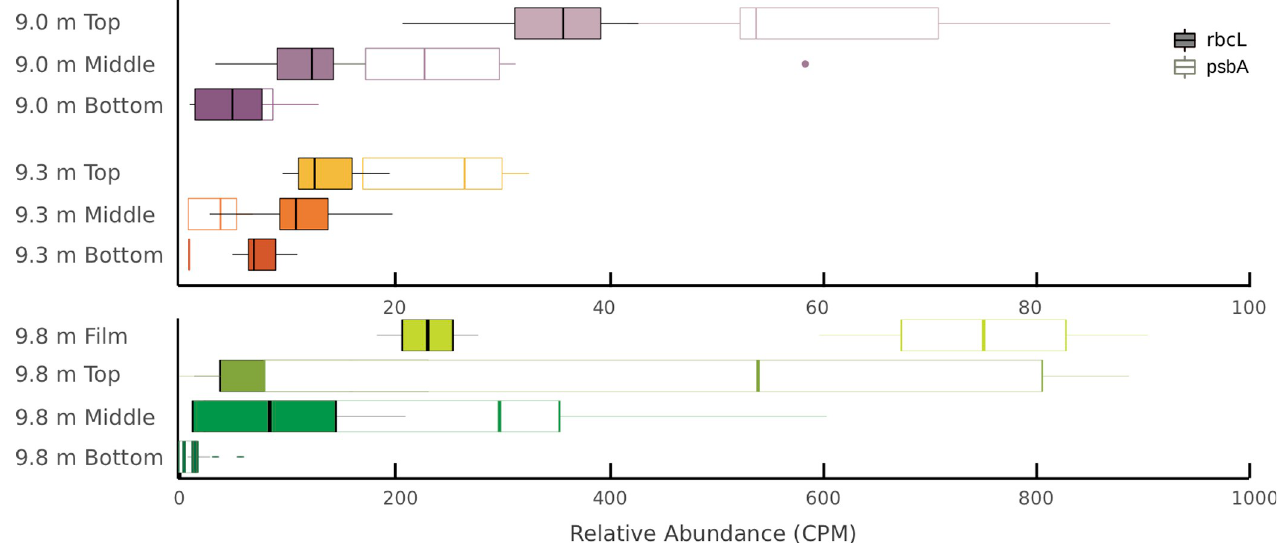
Fig 3. Relative abundances of oxygenic photosynthesis and carbon fixation marker genes. psbA ( open boxes) and rbcL( filled boxes) genes in counts per million from sample metagenomes. Boxplots display the median and first and third quartiles, and the whiskers extend to 1.5 times the interquartile range (IQR). Points outside 1.5IQR are shown individually.